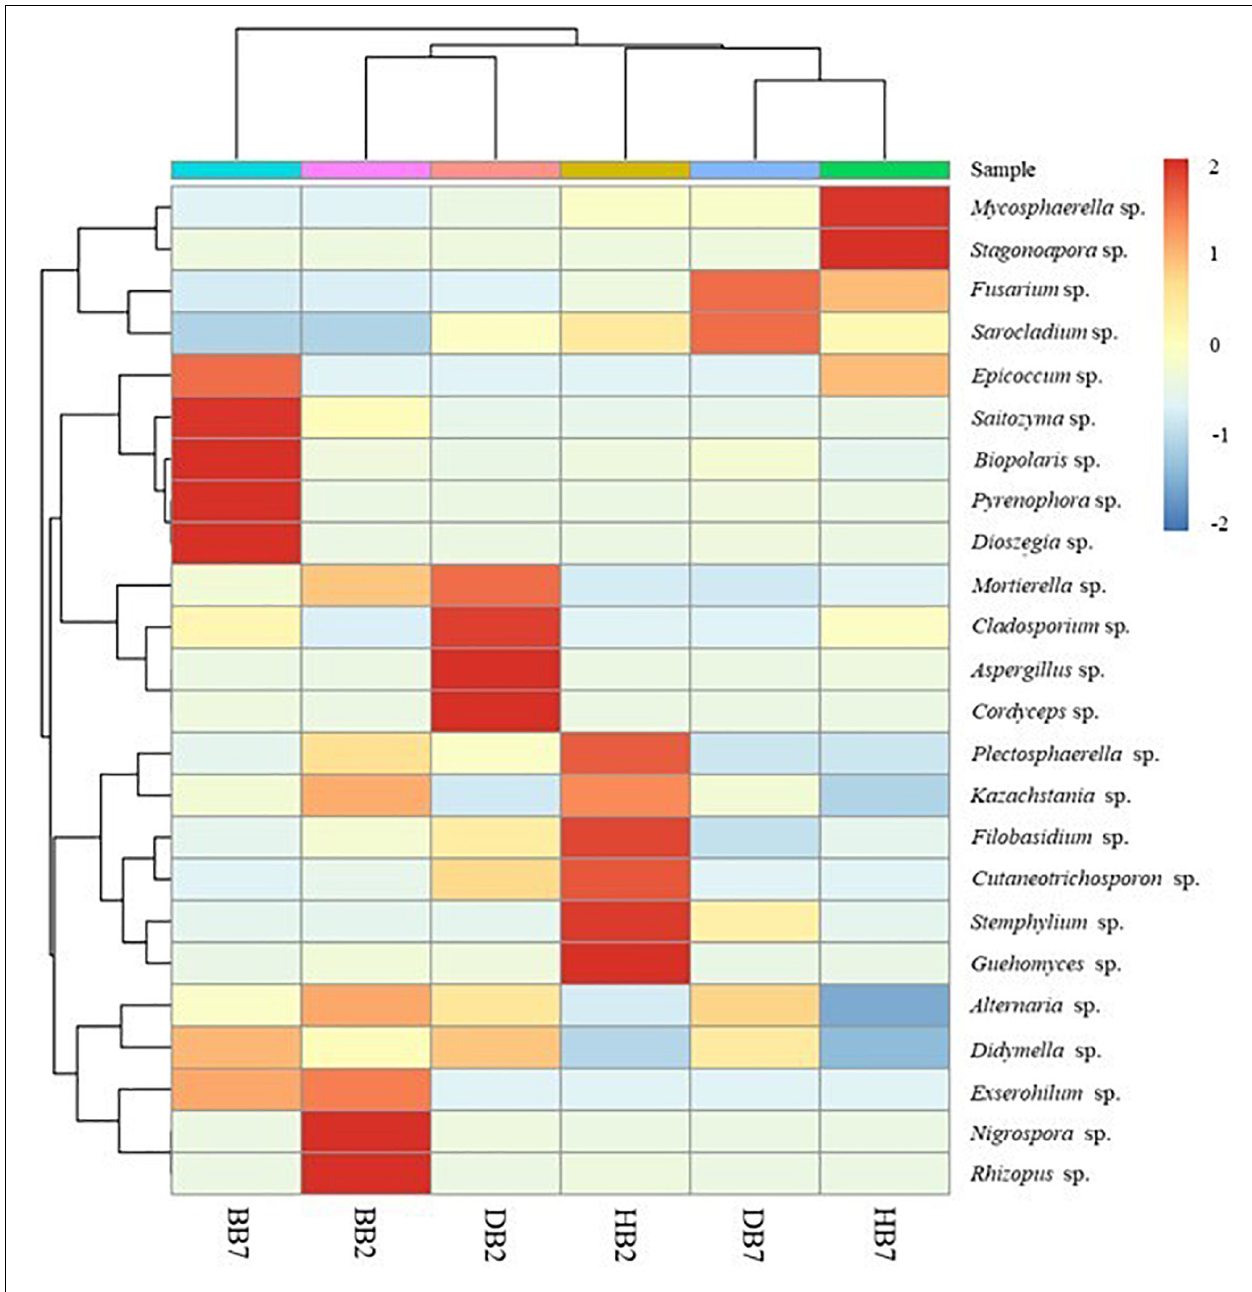
FIGURE 4 | Cluster analysis heatmap of oat seed samples and genus level species